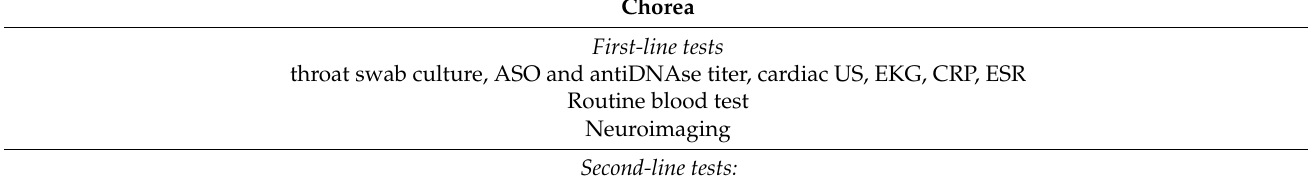
Table 1. Suggested investigations for acute-onset MD, according with the predominant phenomenology (a non-exhaustive list). Chorea First-line tests throat swab culture, ASO and antiDNAse titer, cardiac US, EKG, CRP, ESR Routine blood test Second-line